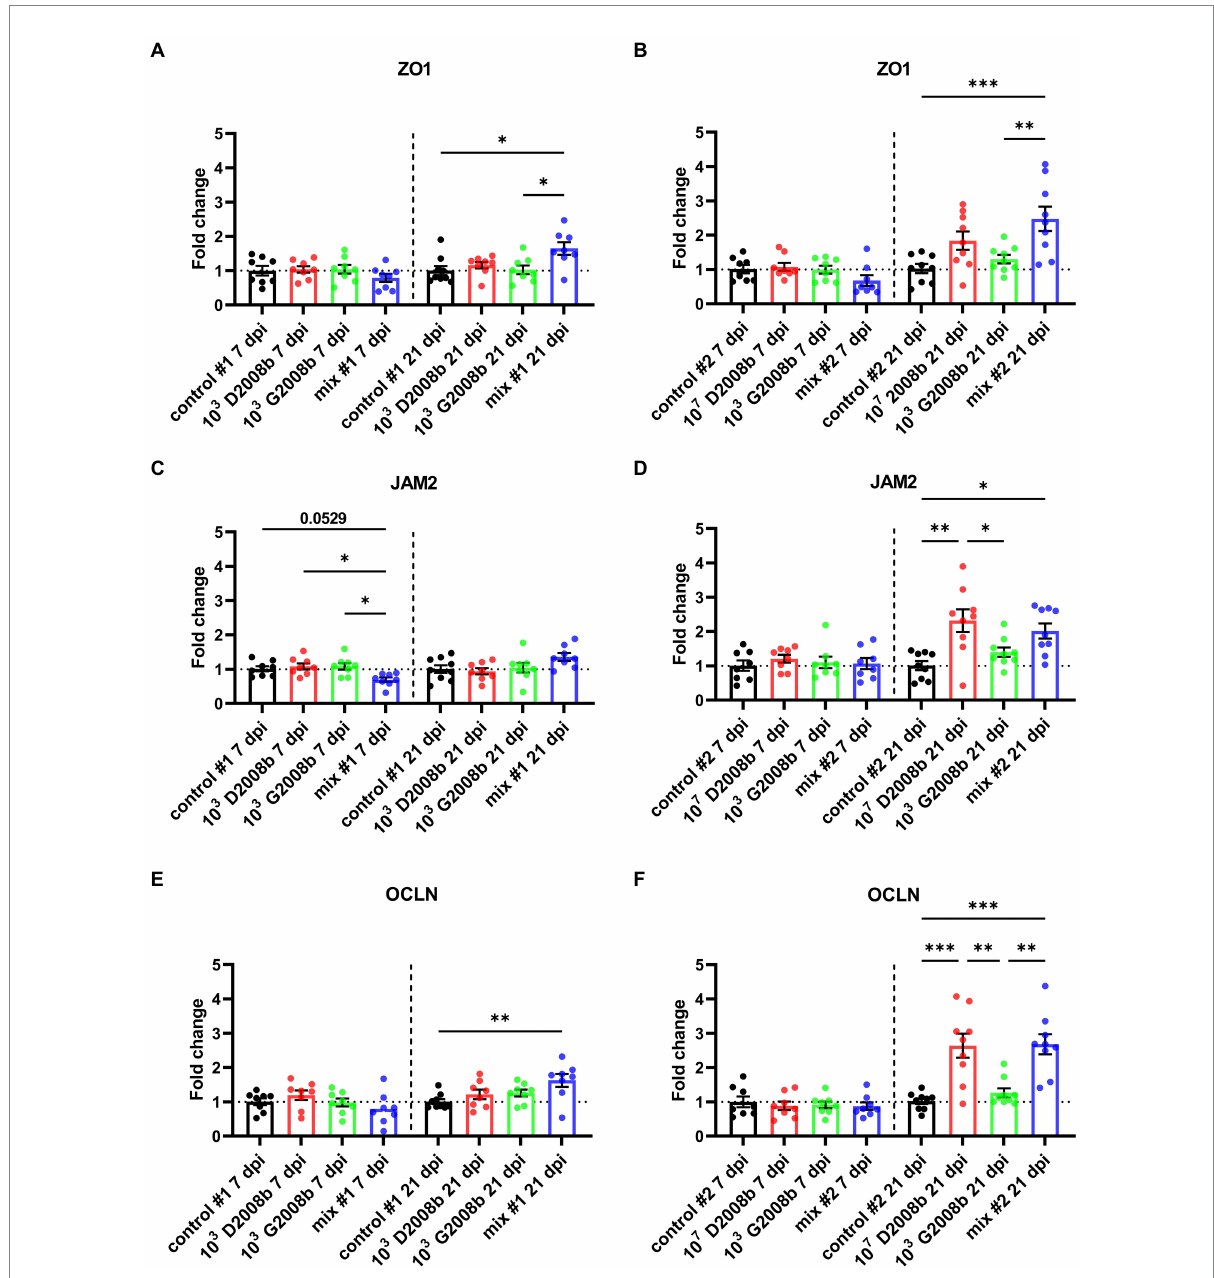
FIGURE 5 Relative gene expression of ZO1 (A,B) , JAM2 (C,D) and OCLN (E,F) in ileal tissue for rooms 1 and 2, respectively, at 7 dpi and 21 dpi. Dots correspond to the protein expression level normalized to two reference genes, RPL32 and β -actin , and to the mean value of the control group. Vertical bars represent mean values ± SEM. ANOVA test followed by Tukey’s multiple comparisons tests were used to analyze statistical differences between chicken groups within the same time point. *, ** and *** indicate p <0.05, p <0.01 and p <0.001 respectively.